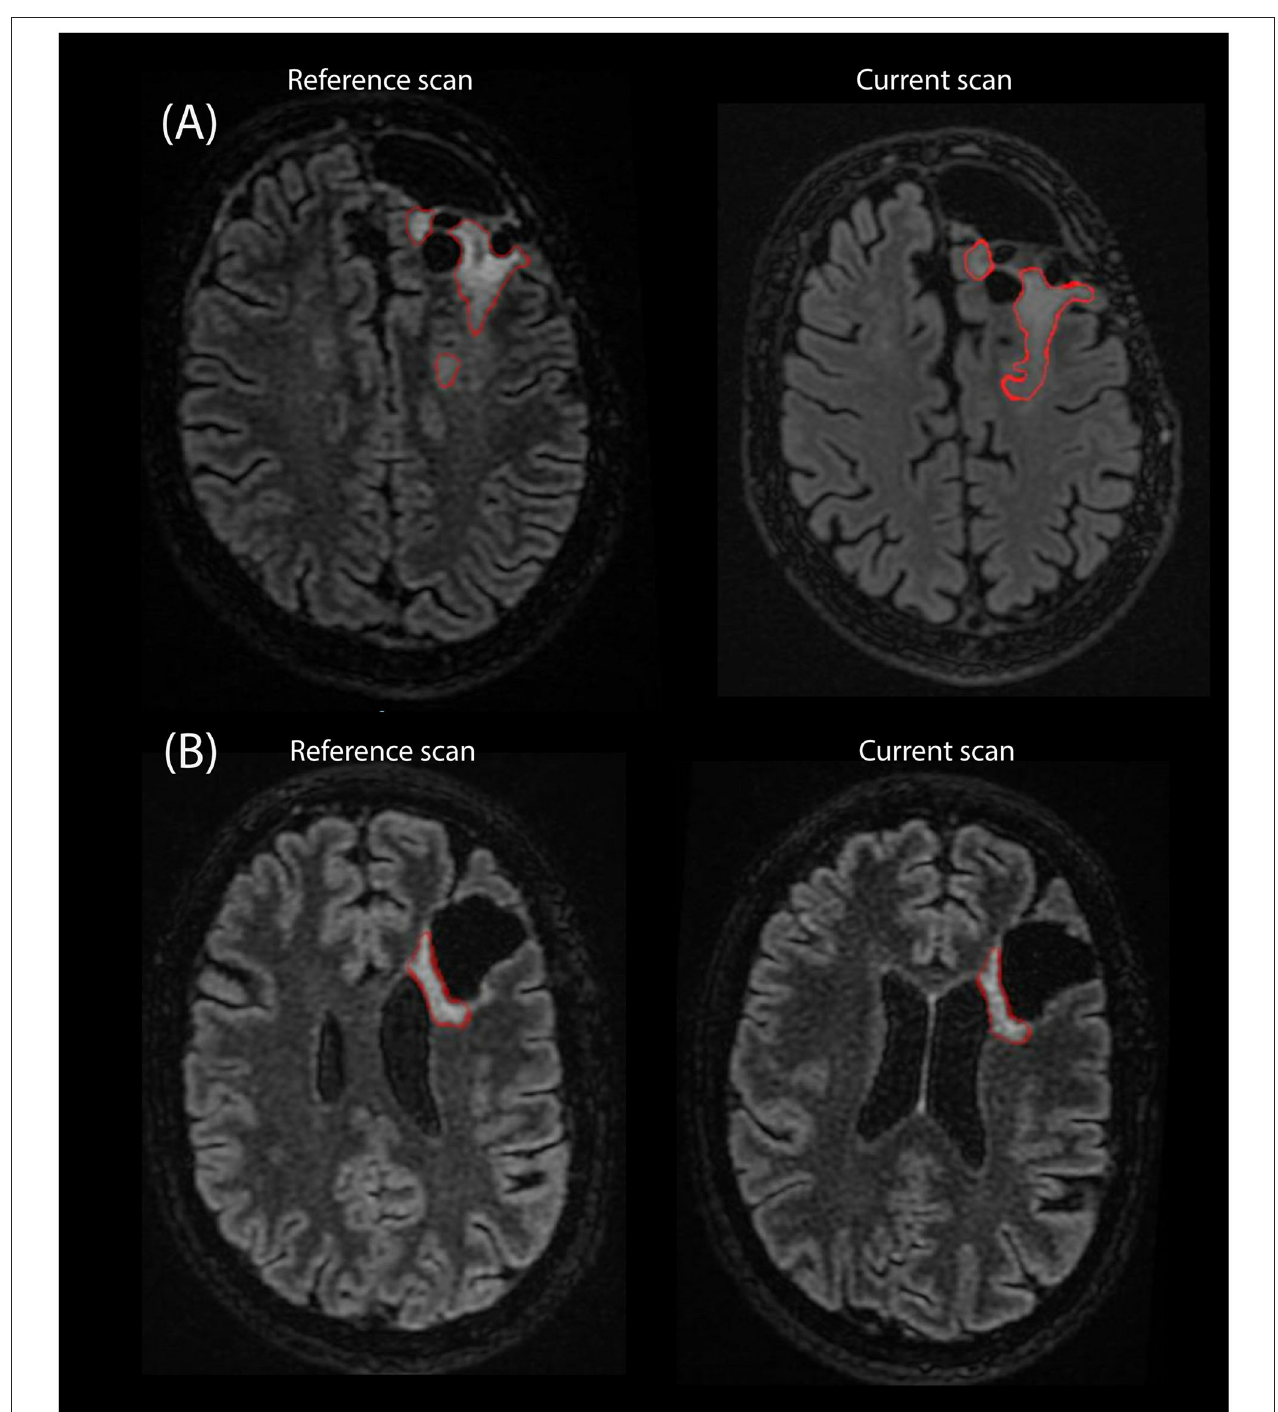
FIGURE 8 | Example of segmentations as they are stored in PACS as an overlay on the T2-FLAIR scan from two consecutive timepoints. (A) Two consecutive scans of patient where EASE segmentations were considered inconsistent by the radiologist. (B) Two consecutive scans where a volume-based diagnosis of stable disease could be